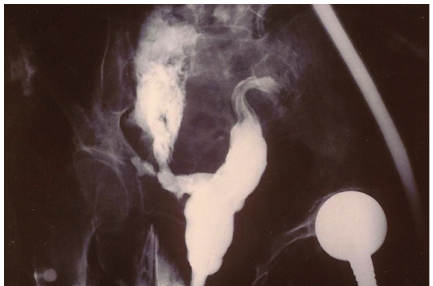
Figure 3: Plain anteroposterior radiograph showing the pelvis 5 minutes after per rectum administration of gastrografin. A rectal perforation allows gastrografin to escape into the pelvic cavity.